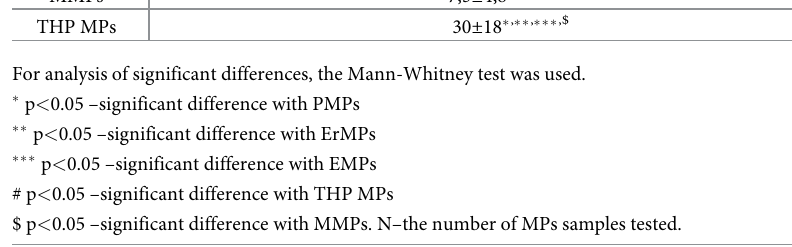
THP MPs 30 ± 18 � , �� , ��� ,$ 6 For analysis of significant differences, the Mann-Whitney test was used.